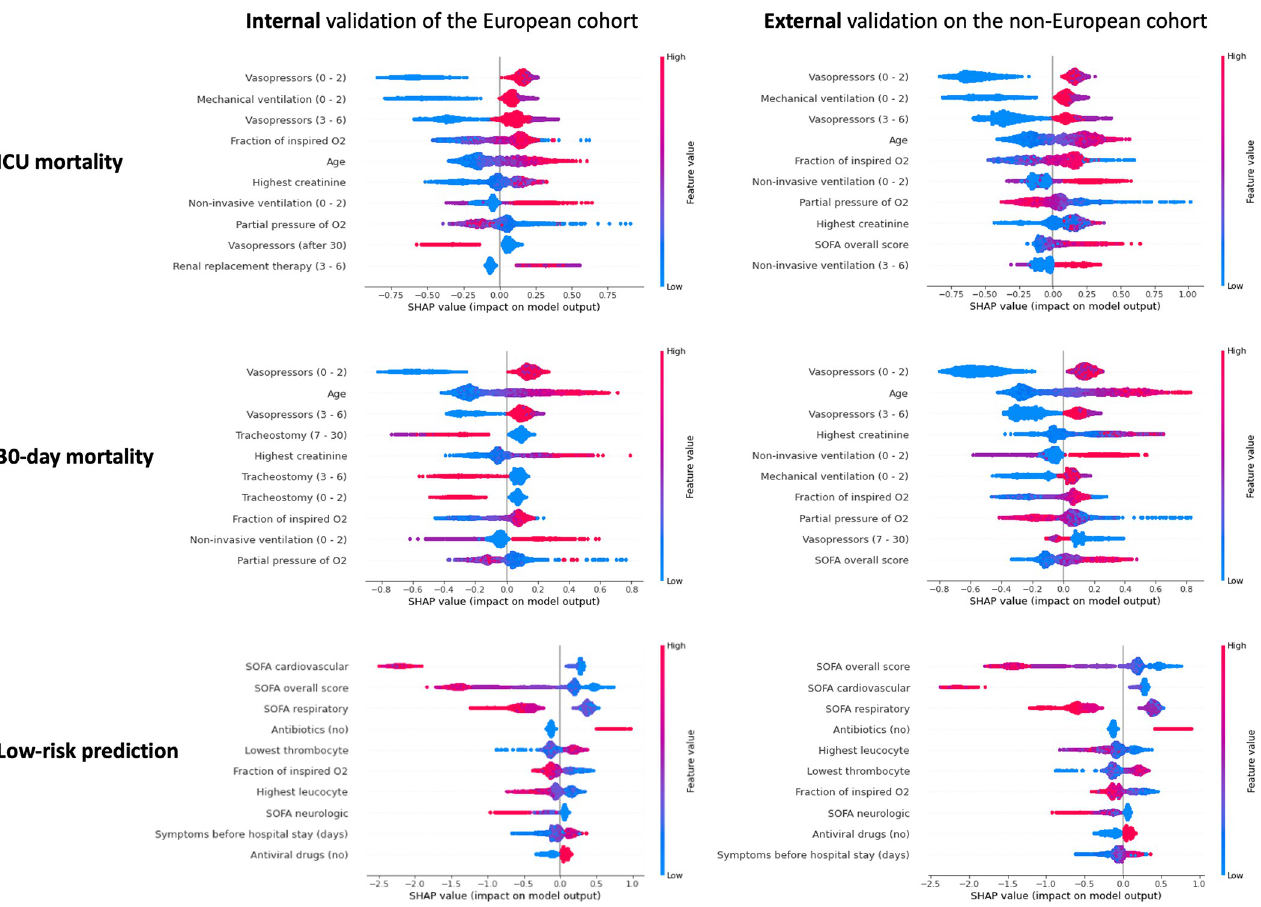
Fig 8. SHAP summary plots showing the top-10 most important variables for each of the three outcomes of interest, when evaluating the European model internally (left) as well as externally on the non-European cohort (right). Colour represents the actual value of the variables (red indicating higher values), while the higher the SHAP value of a variable (depicted in the x-axis), the higher the estimated probability of the outcome. For some variables we also indicate the interval of occurrence, for example “Vasopressors (0–2)” indicates administration of vasopressors during the first 2 days from the admission.